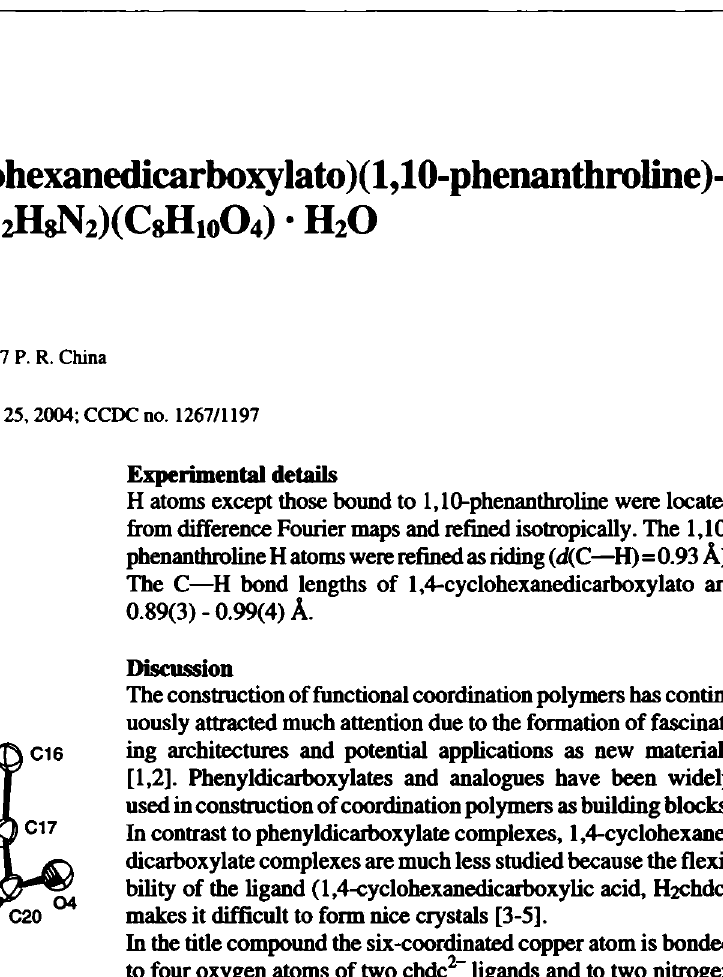
Table 1. Data collection and handling.